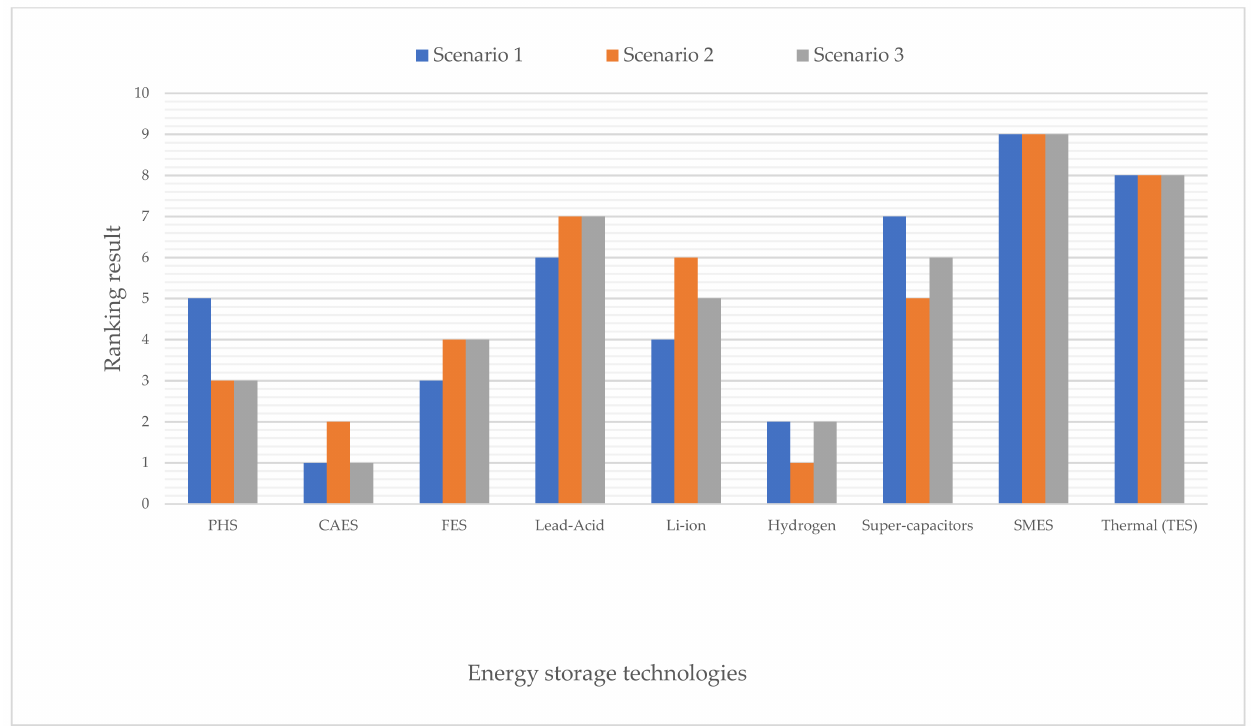
Figure 8. The ranking results in Scenario 1, Scenario 2, and Scenario